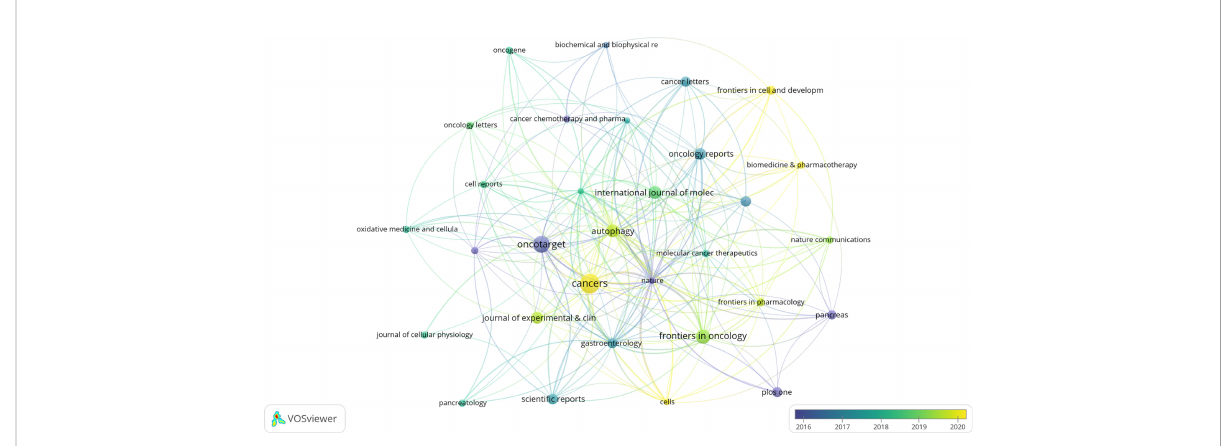
FIGURE 4 The overlay visualization map of journals associated with research on autophagy of pancreatic cancer. The layout parameters: Attraction: 4, Repulsion: -1. The circle size means the number of publications; the circle colors mean the average published